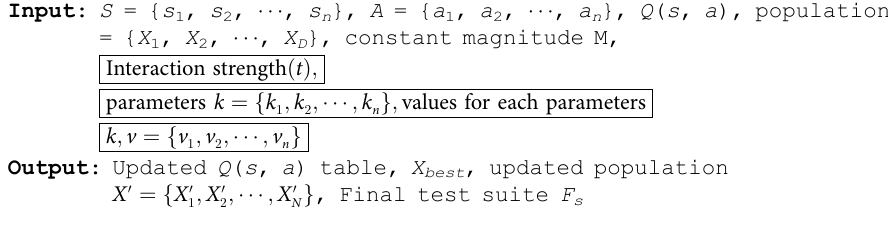
Algorithm 5 : The QLSCA